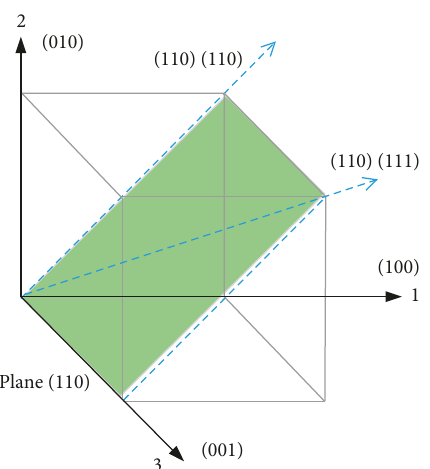
Figure 1: Selected FCC single crystal directions for analysis.